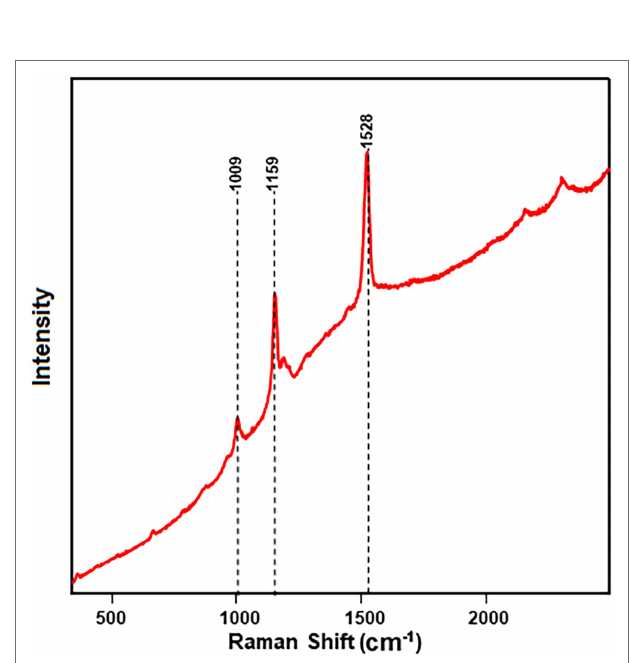
FIGURE 2 | Resonance Raman spectra of carotenoid-rich fraction show prominent bands related to carotenoids obtained from the rind of the Fascination type